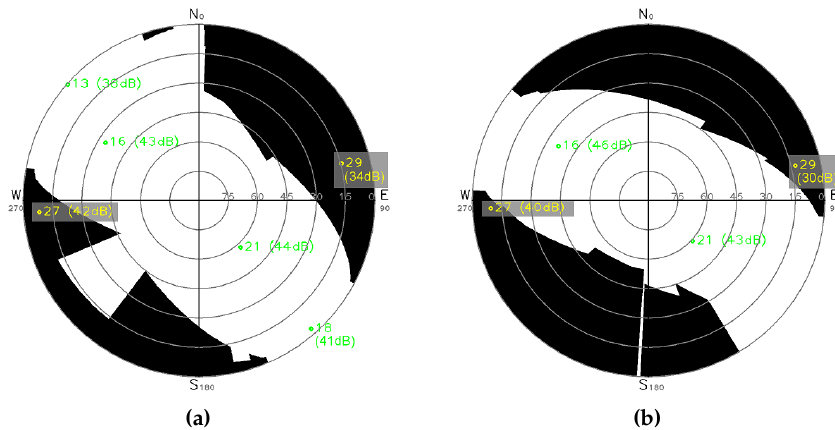
Figure 14. Skyplots and visibility masks for presented sequences. Green satellites are LOS and yellow ones bounded in grey are detected NLOS according to the mask. ( a ) Cap3/0900; ( b )